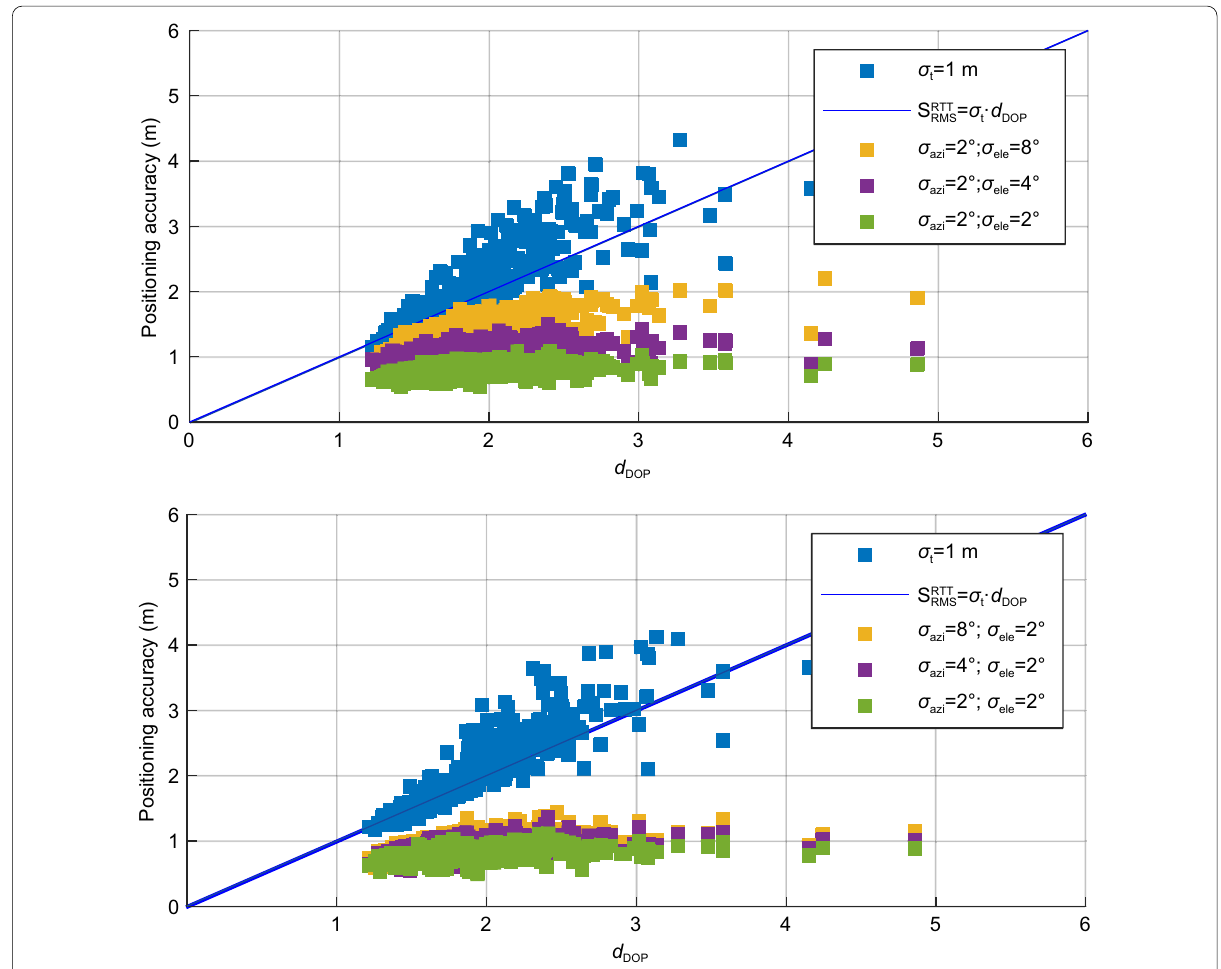
Fig. 7 Relationship between positioning accuracy and observation accuracy in RTT/AOD positioning